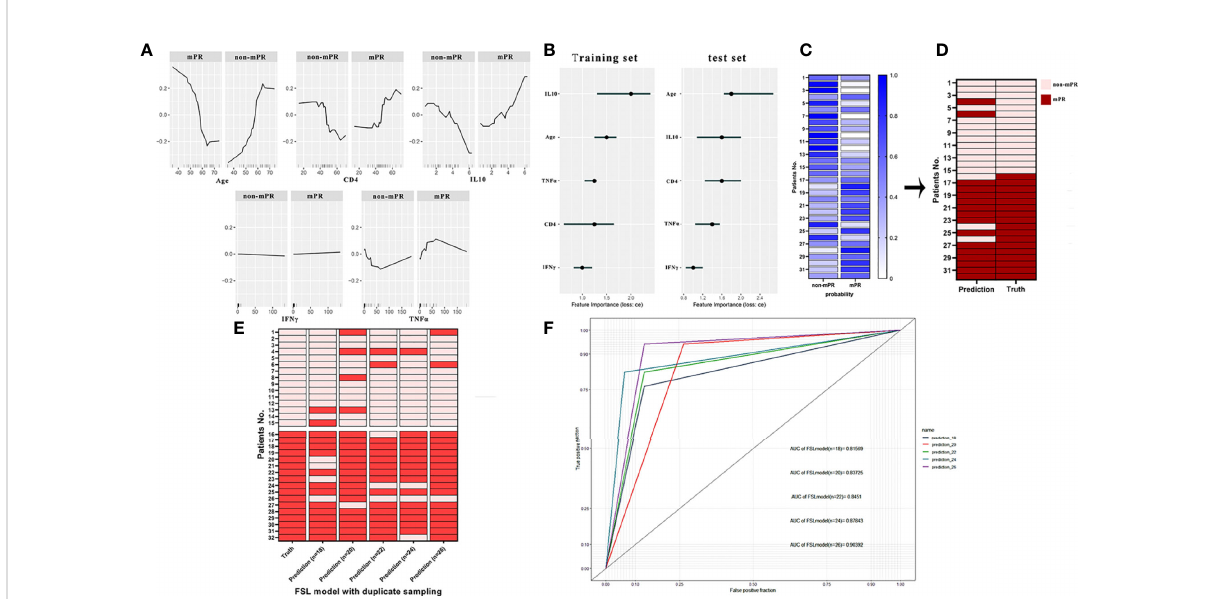
FIGURE 5 (A) The partial dependence plot (PDP) of age, CD4, IFN g , TNF a , and IL-10 showed the marginal effect features on the predicted mPR outcome of the FSL model. (B) The feature importance of age, CD4, IFN g , TNF a , and IL-10 in the training set and test set. (C) Probabilities of predictive outcomes of each patient in the fi nal FSL model. (D) Comparison of authentic mPR outcome and predictive outcome of each patient computed by the FSL model. (E) Heatmap of actual outcomes and predictive outcomes of the FSL model trained by different training sets. (F) ROC analysis of the FSL model trained by different training sets. The receiver operating characteristic curve